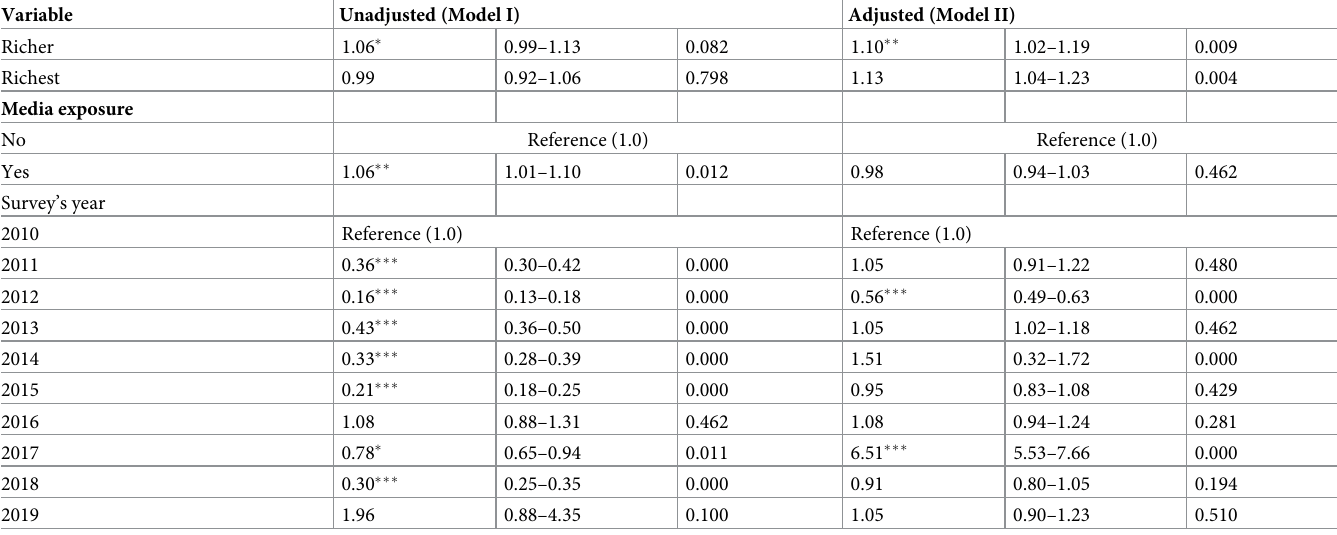
Model 1: unadjusted model examining the independent association of child’s sex and breastfeeding initiation; Model 2: adjusted for the covariates; AOR is the adjusted odds ratio, COR is the unadjusted odds ratio; Exponentiated coefficients; 95% CI is the 95% confidence intervals. � p < 0.05 �� p < 0.01 ��� p <